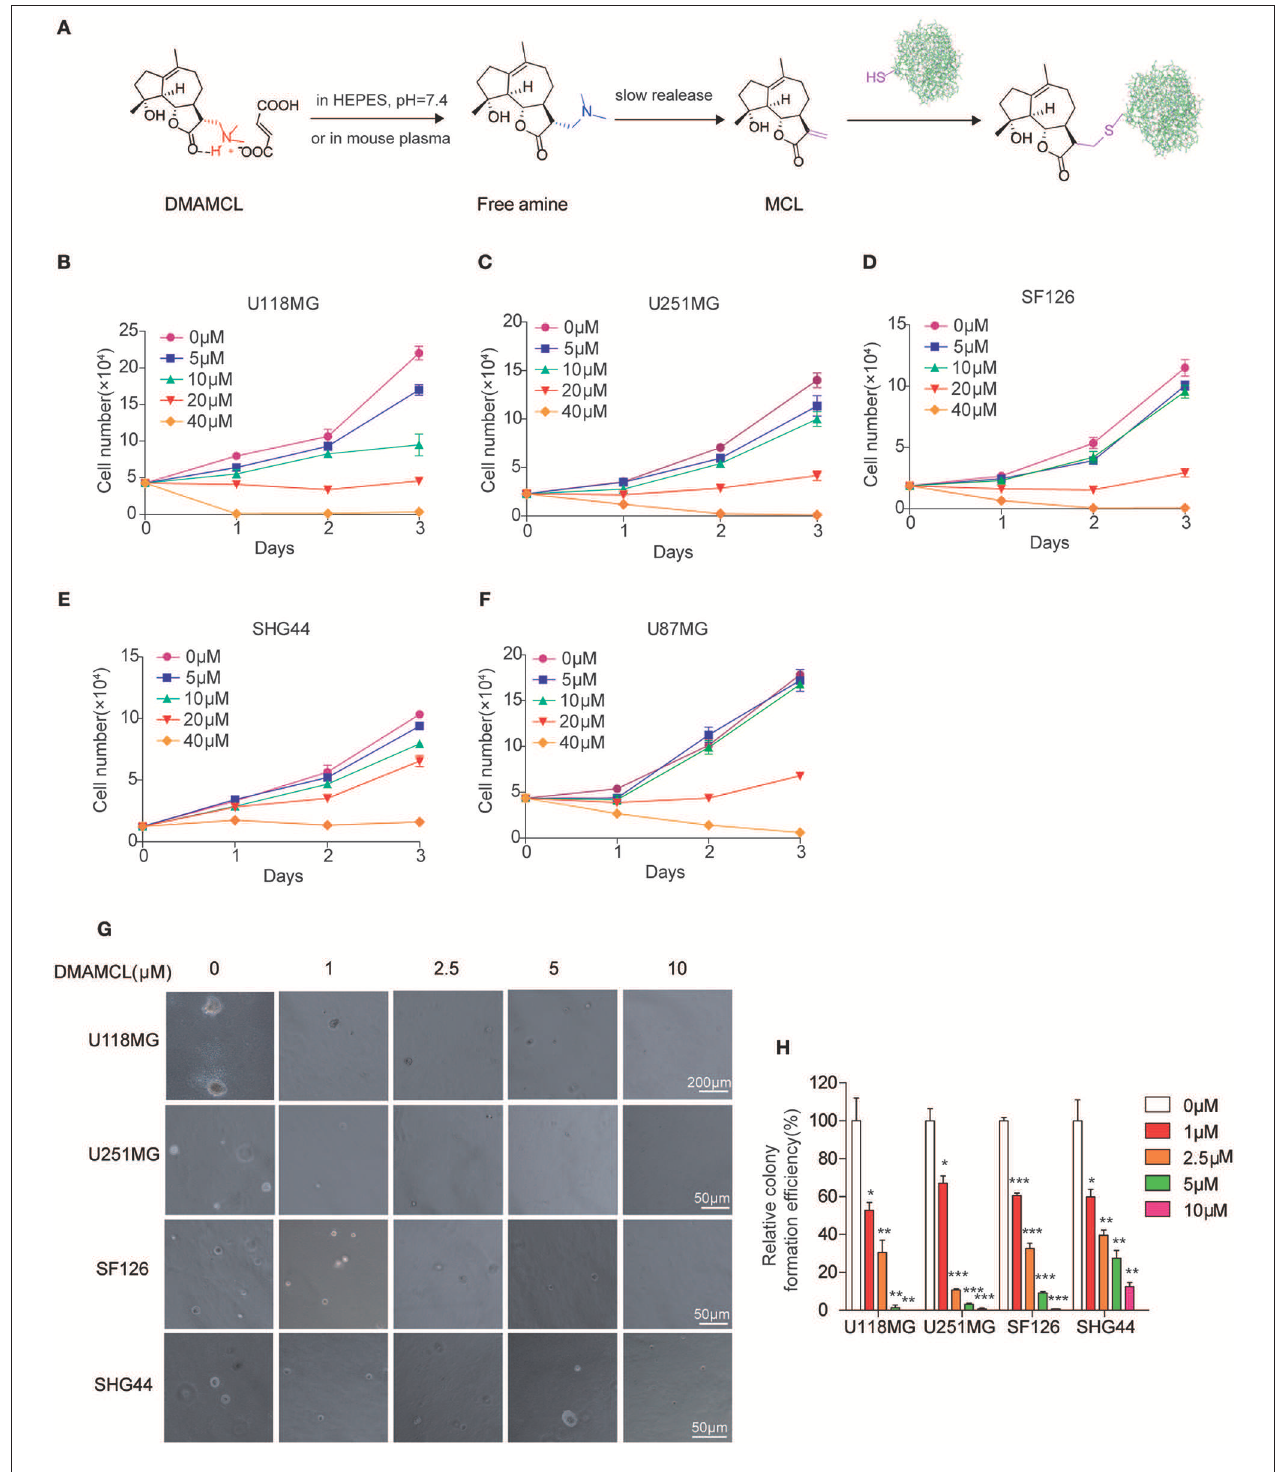
FIGURE 1 | DMAMCL reduces the proliferation of malignant glioma cells and the colony formation through release MCL. (A) The release of MCL from DMAMCL. In HEPES buffer, pH = 7.4 or mouse plasma, DMAMCL slowly release MCL. The α -methylene- γ -lactone group of MCL are able to act as a Michael acceptor to form a covalent bond with the thiol group of cysteine residue. (B–F) U118MG, U251MG, SF126, SHG44, U87MG cells were grown and treated with DMAMCL at 0–40 µ M for 24, 48, and 72h, respectively. The number of cells was counted. (G) Representative malignant glioma colony formation assays from four different cell lines treated with DMAMCL at 0–10 µ M for 14 days. (H) The statistic of the relative colony formation efficiency. Error bars, mean ± s.e.m., n = 3 biological replicates. * P < 0.05, ** P < 0.01, *** P < 0.001.